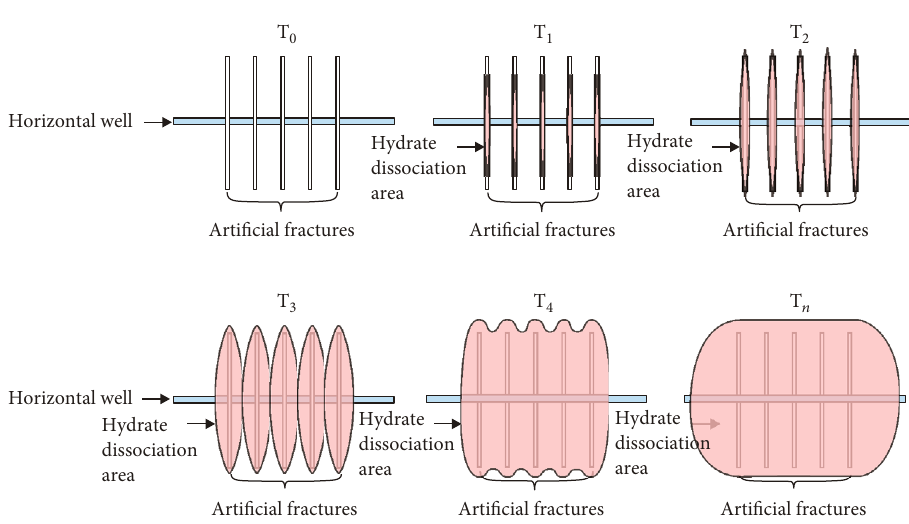
Figure 1: Illustration of hydraulic fracture in the hydrate dissociation area for a horizontal well.